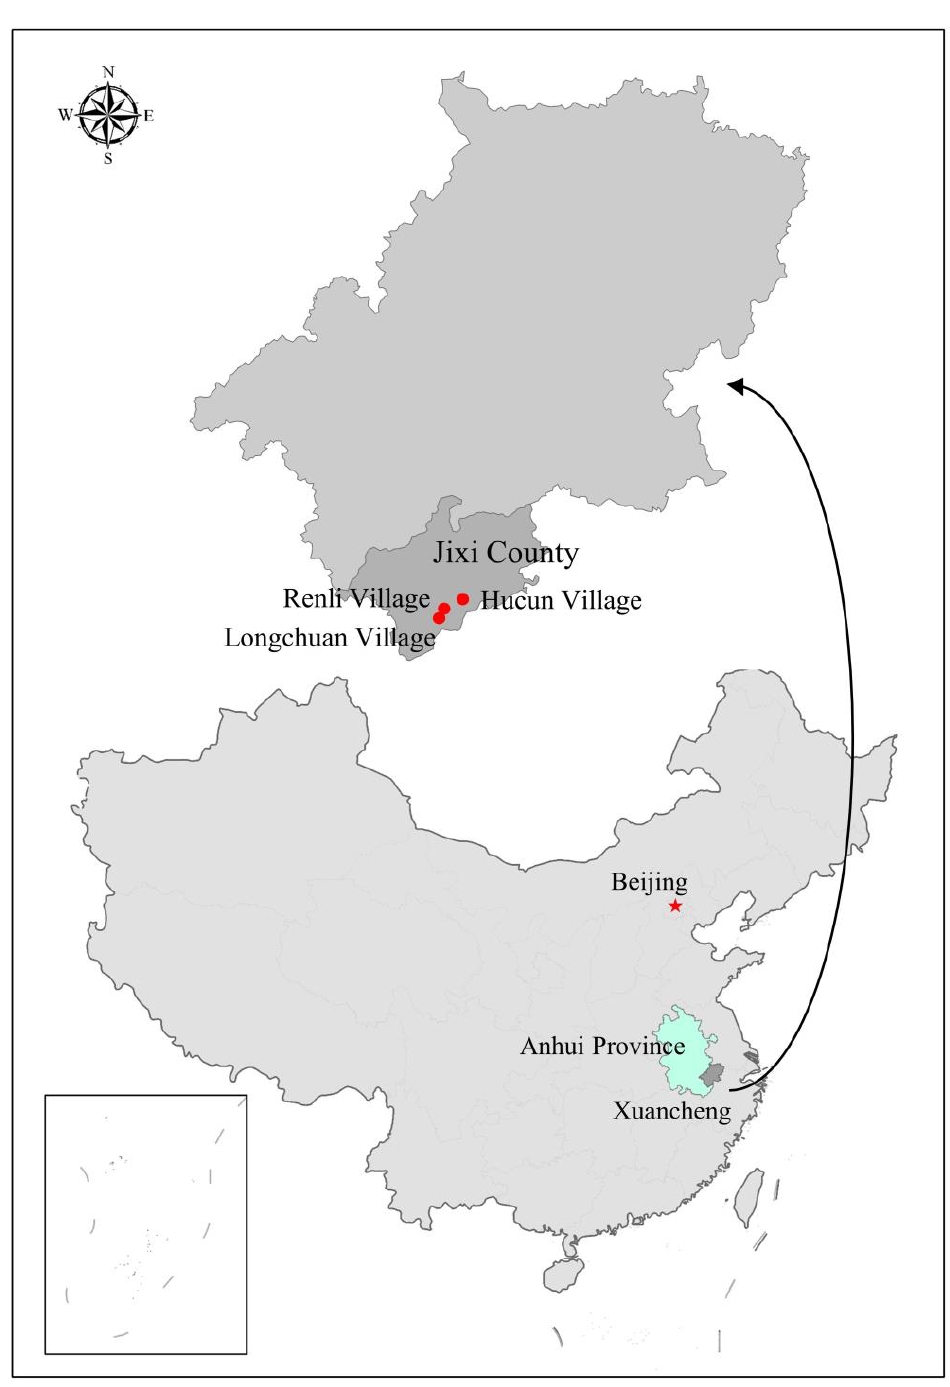
Figure 1. Location of study area.